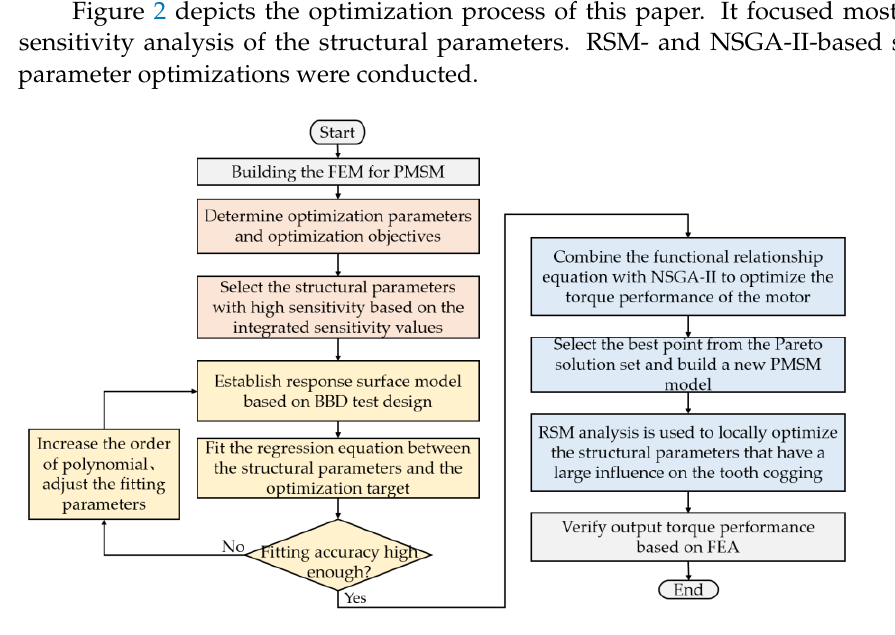
Figure 2. Optimized flow chart of SPMSM.